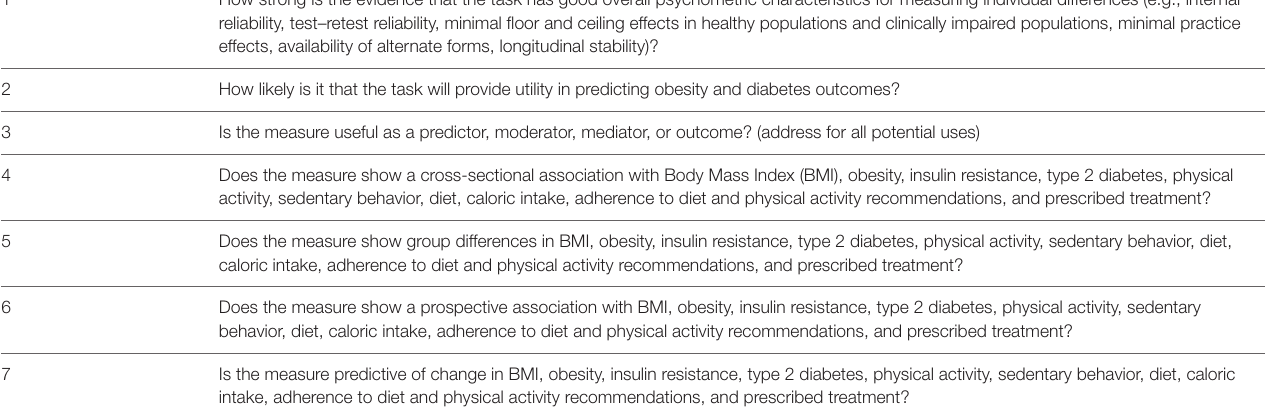
TABLE 2 | High priority criteria used for task